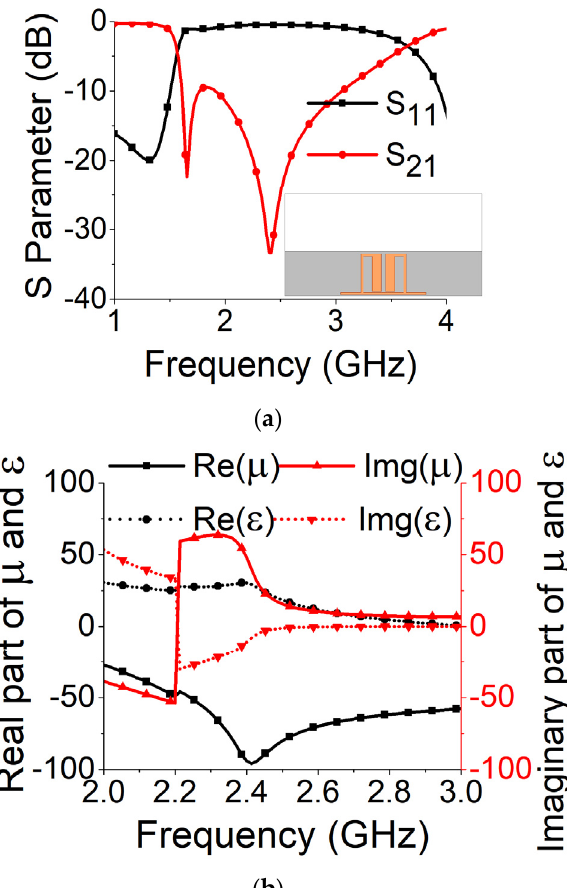
Figure 4. Split ring resonator (SRR)-based bandstop filter: ( a ) S parameters; ( b ) permittivity ( ε ) and permeability (µ).